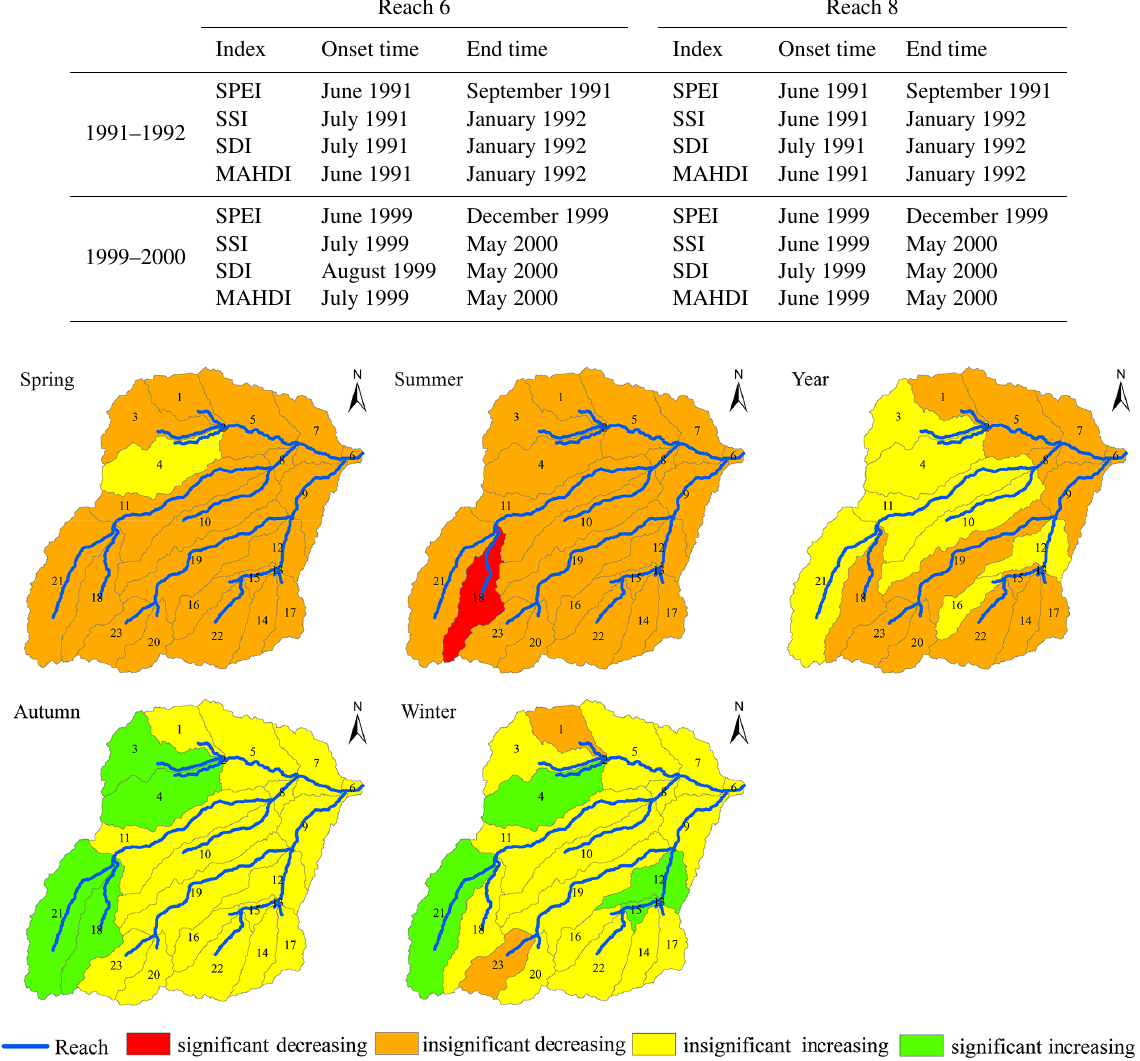
Figure 7. M–K trend test of MAHDI at 3- and 12-month scales in